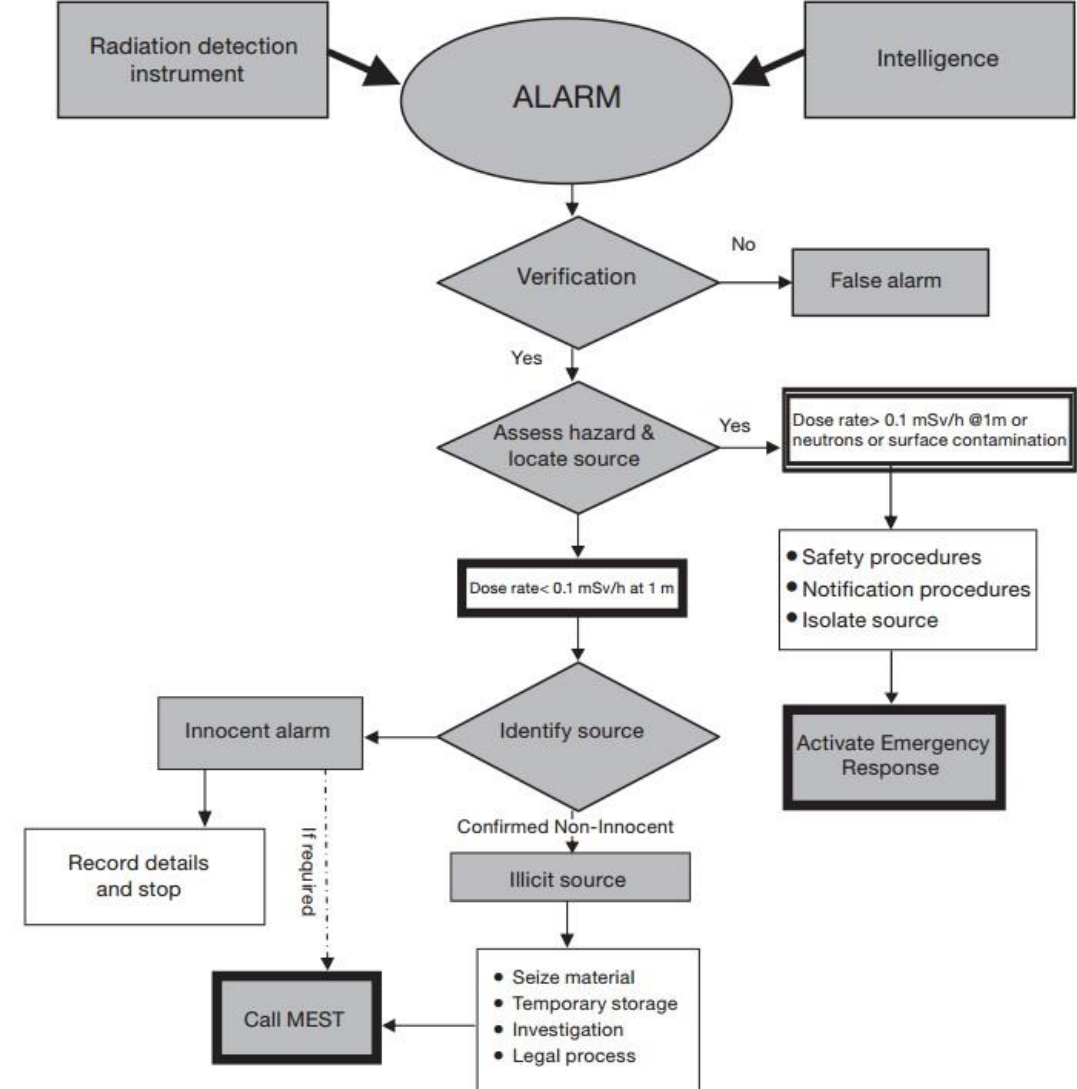
Figure 1: Alarm procedure recommended by the IAEA [ 3 ]. MEST stands for mobile expert support